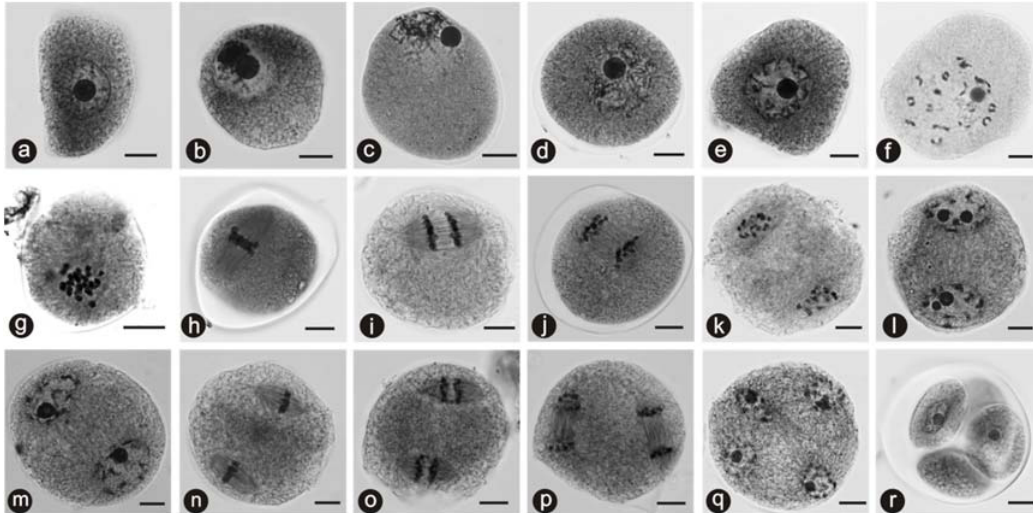
Figure 4. Microsporogenesis of rubber tree RRIM 600 (scale bar = 10 μ m). ( a ) Early leptotene; ( b , c ) Late leptotene; ( d ) Pachytene; ( e , f ) Diplotene; ( g ) Diakinesis; ( h ) Metaphase I; ( i – k ) Anaphase I;